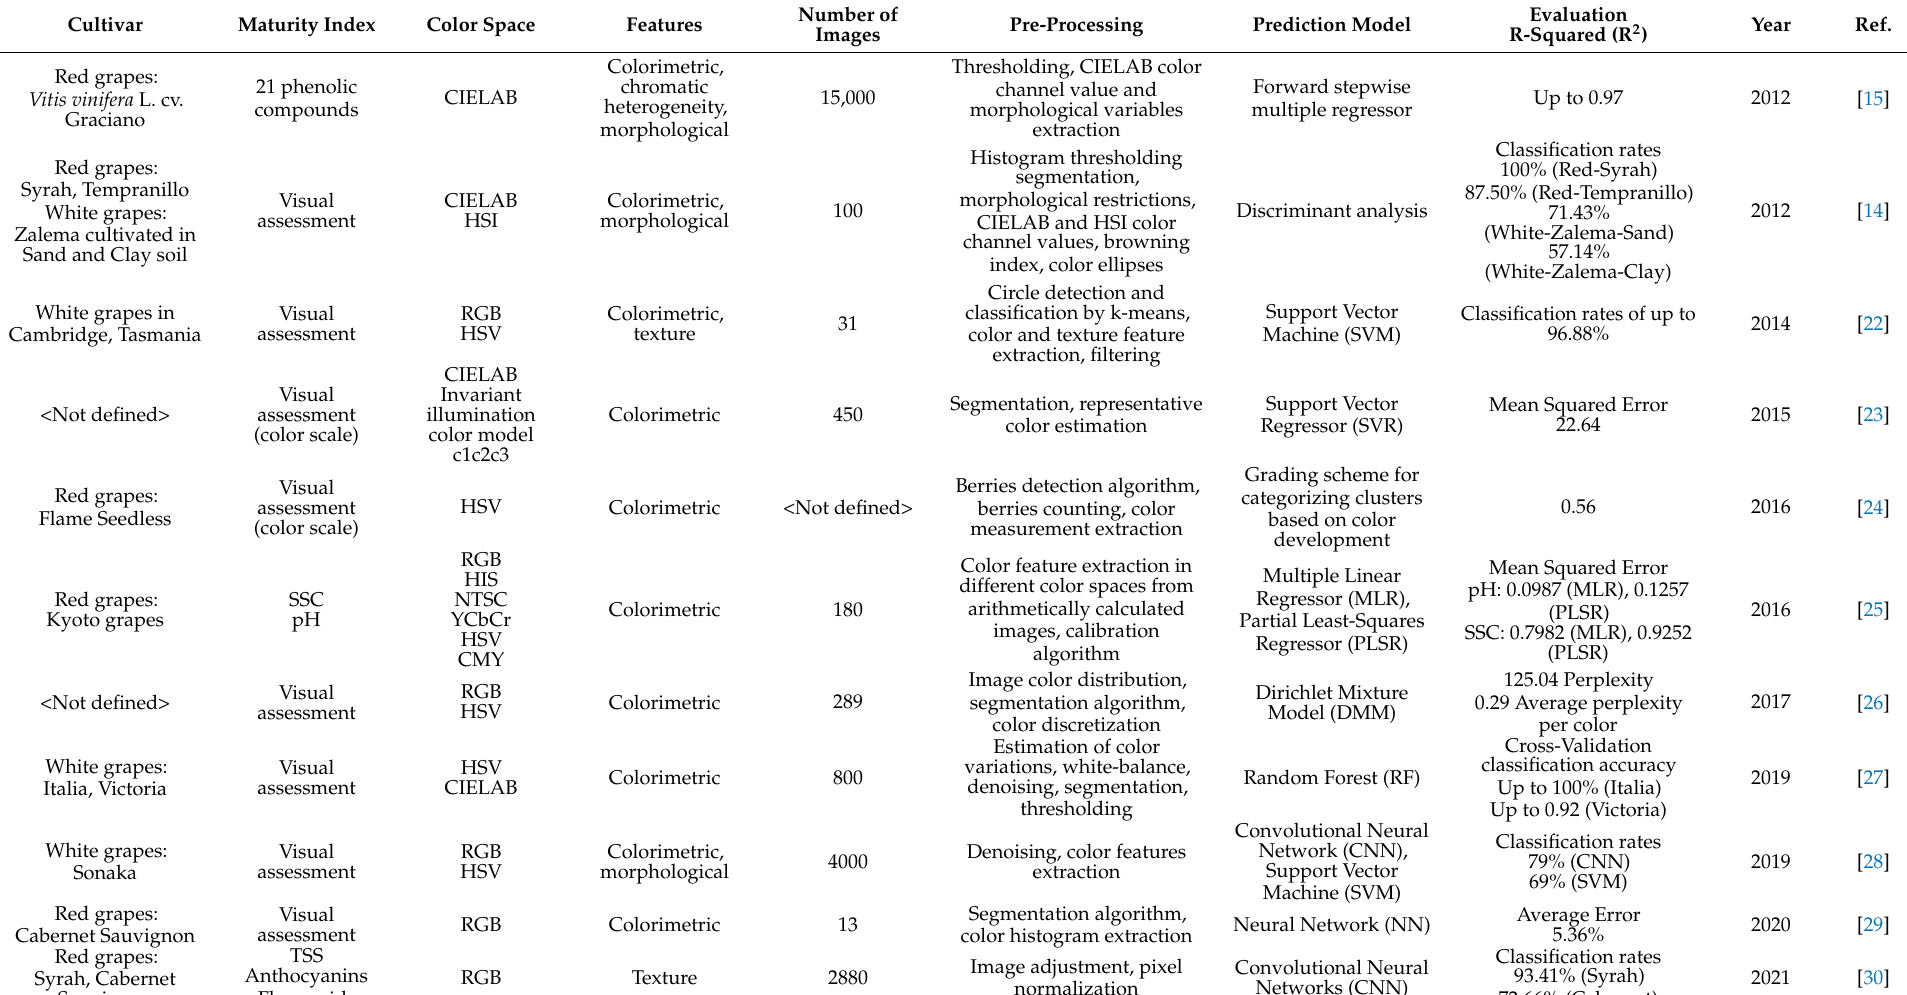
Table 4. Applications of color imaging for grape ripeness